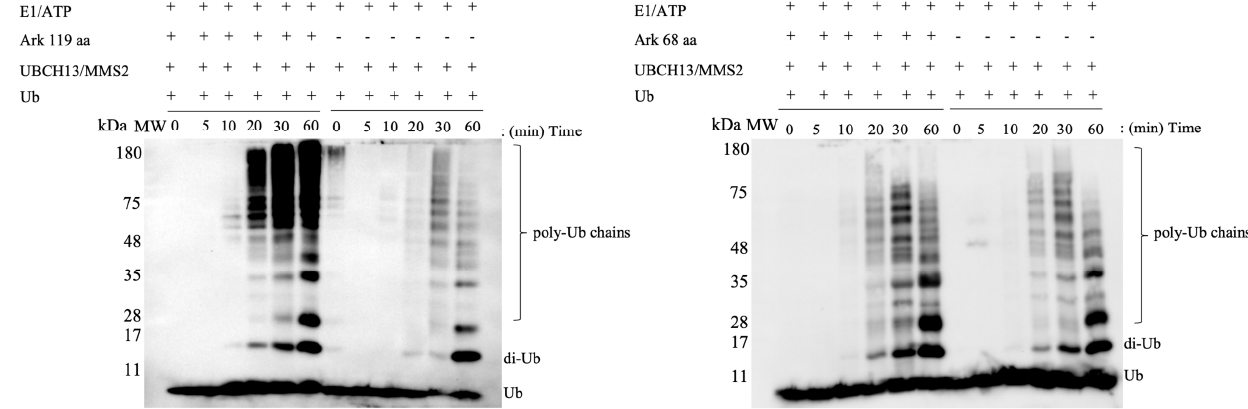
Figure 4. In vitro ubiquitination assays showing the formation of unanchored K63-linked chains after incubation of either Ark 68 aa or Ark 119 aa polypeptides using UBCH13/MMS2 E2 enzymes complex. All ubiquitination experiments were performed three times